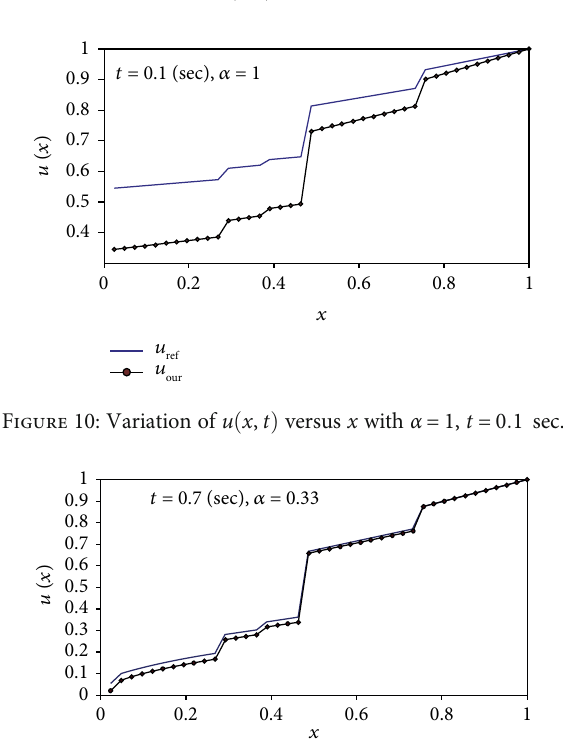
Figure 9: Variation of u ð x , t Þ versus x with α = 1 , t = 0 : 3 sec .